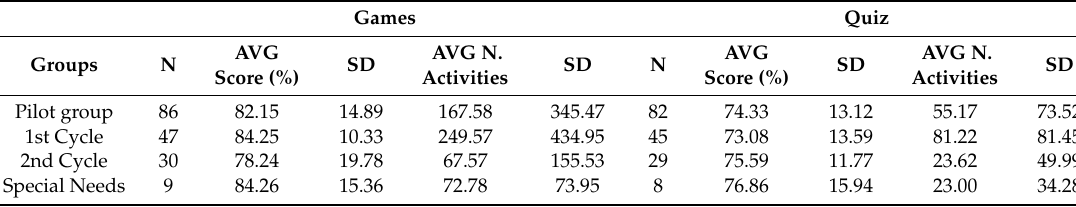
Table A6. Descriptive statistics scores at all games and quizzes played by Pilot Group 3. Games